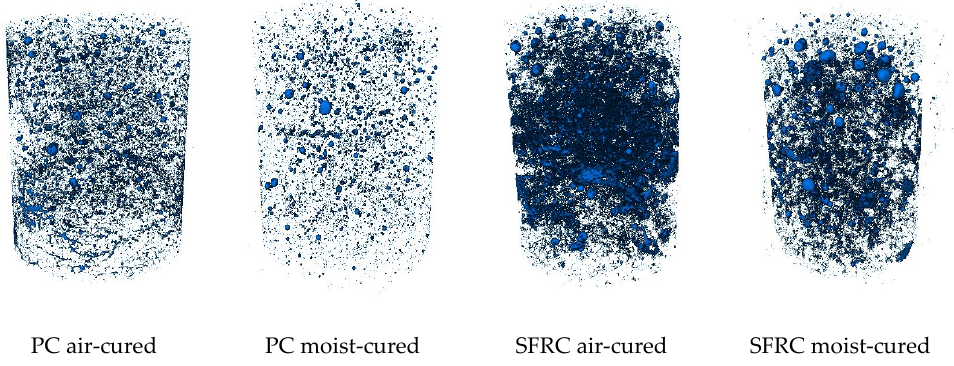
Figure 4. Three-dimensional views of the pores belonging to different mixtures and curing